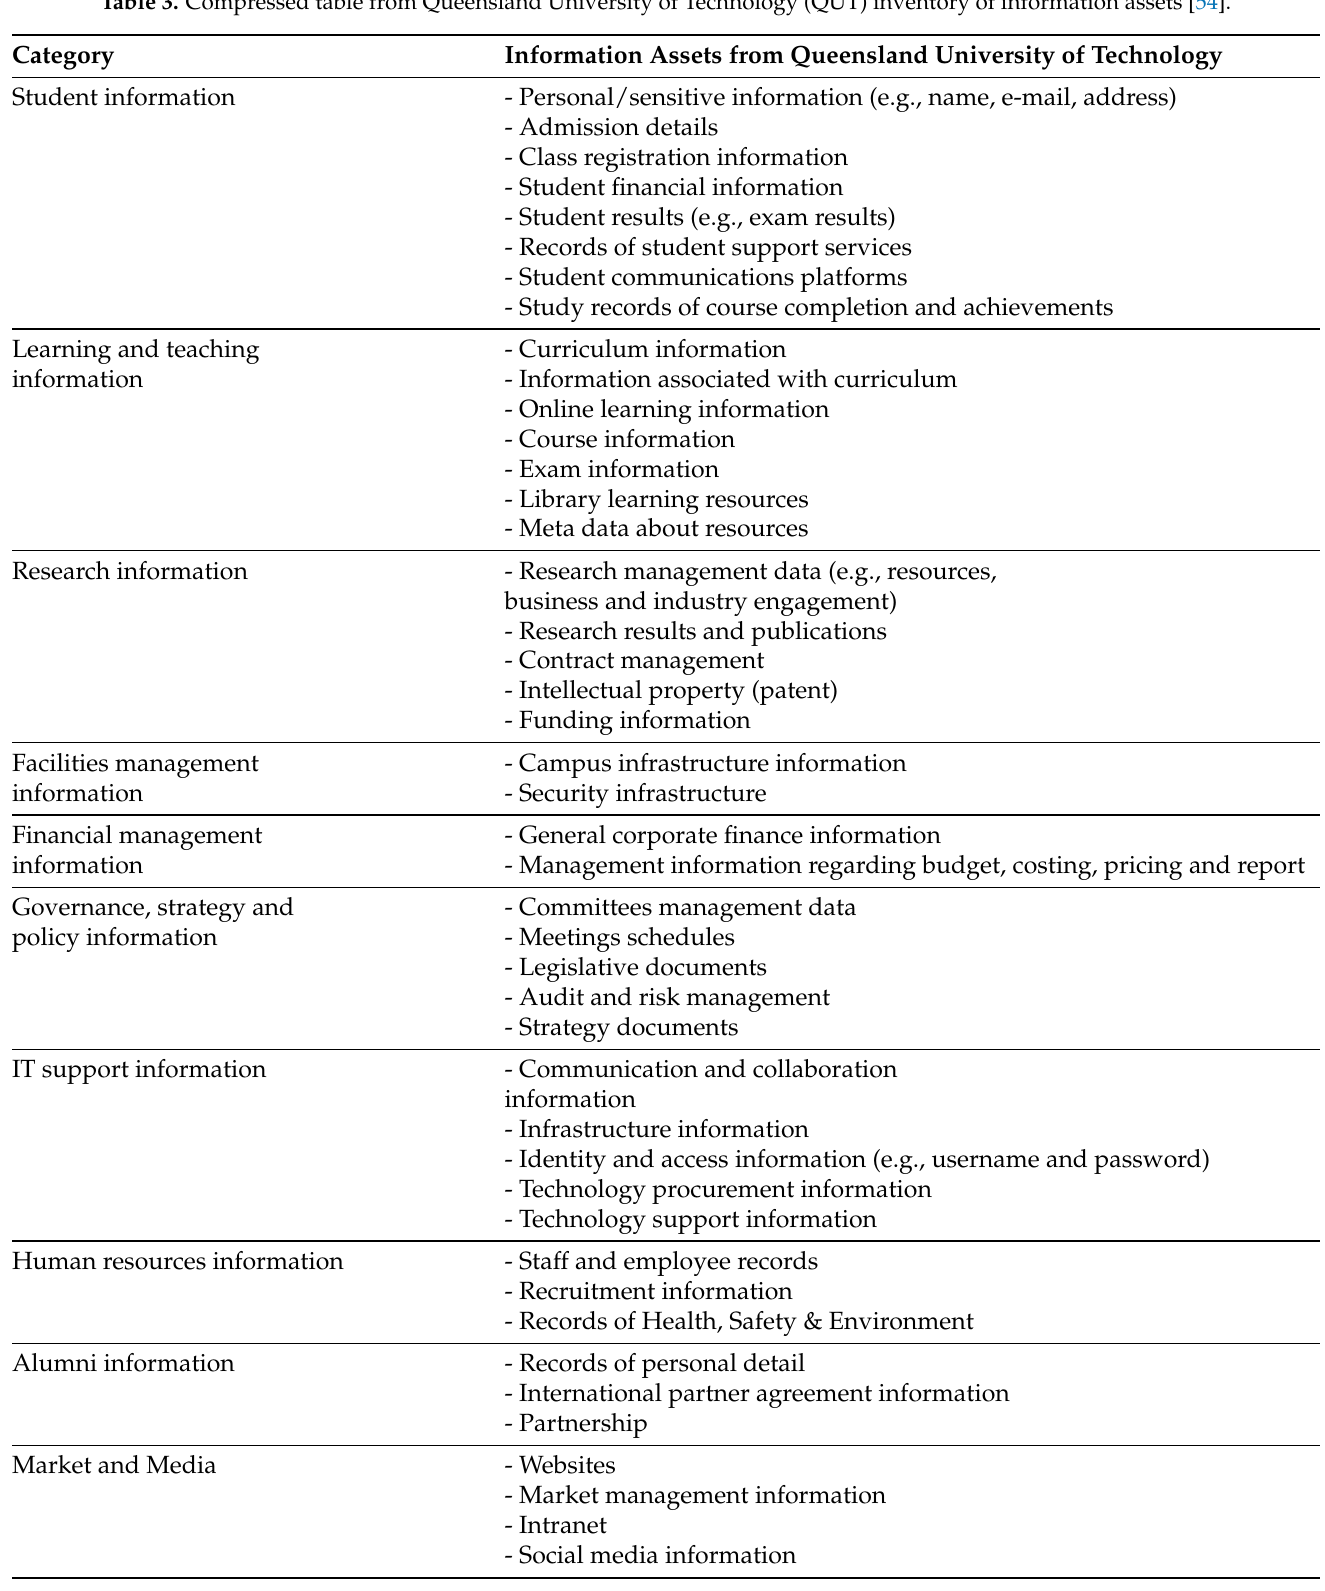
Table 3. Compressed table from Queensland University of Technology (QUT) inventory of information assets [54].